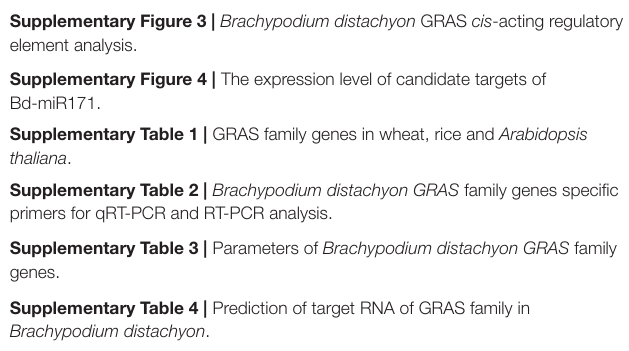
Supplementary Table 3 | Parameters of Brachypodium distachyon GRAS family genes. Supplementary Table 4 | Prediction of target RNA of GRAS family in Brachypodium distachyon